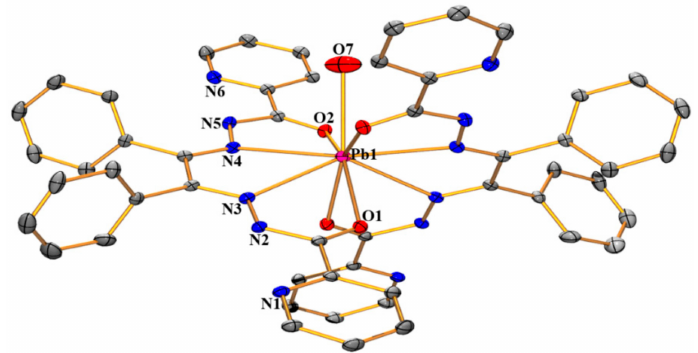
Figure 7. Molecular view of compound ( 3 ) with partial atom numbering. The unlabeled counterpart is generated through the symmetry operation (2 − x, y, 1 / 2 − z). Ellipsoids have been generated at the 30% probability.